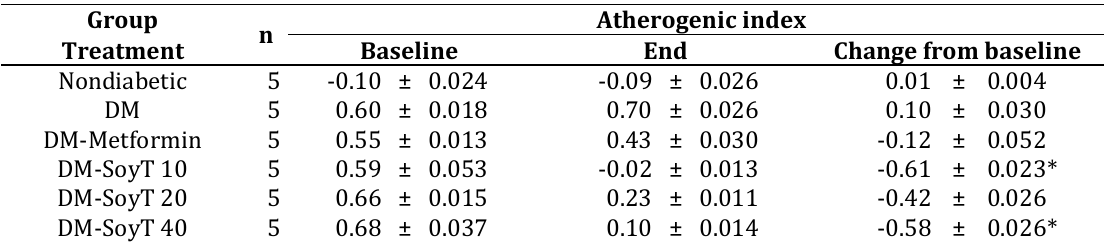
Table VI. The atherogenic index after 3 weeks of treatment Group Atherogenic index n Treatment Baseline End Change from baseline Nondiabetic